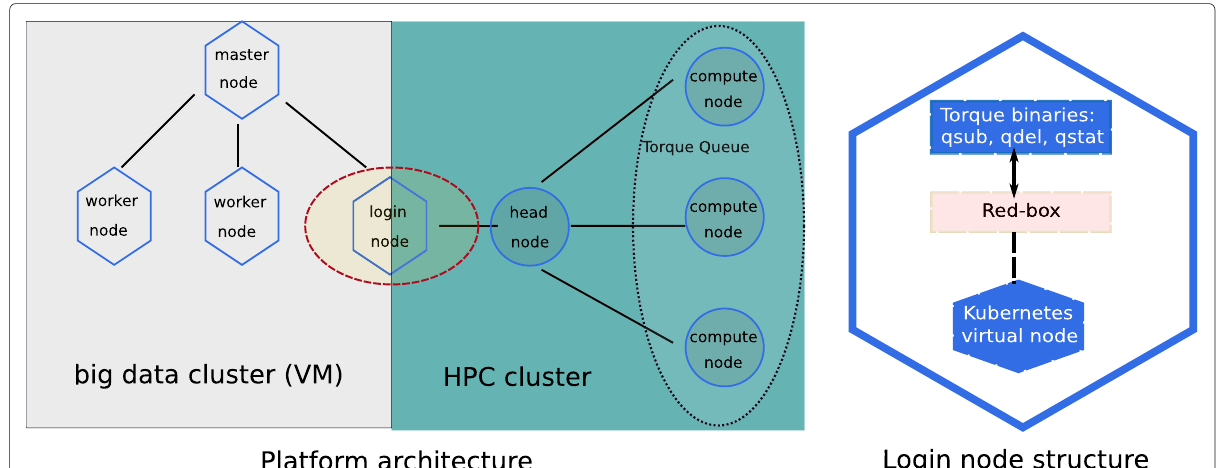
Fig. 4 Platform architecture. The login node belongs to both the Kubernetes and TORQUE clusters. The HPC cluster encompasses only one queue in the figure. The virtual node (inside the login node structure) on the right figure corresponds to the TORQUE queue on the left figure. Multiple virtual nodes can be generated when multiple TORQUE queues exist